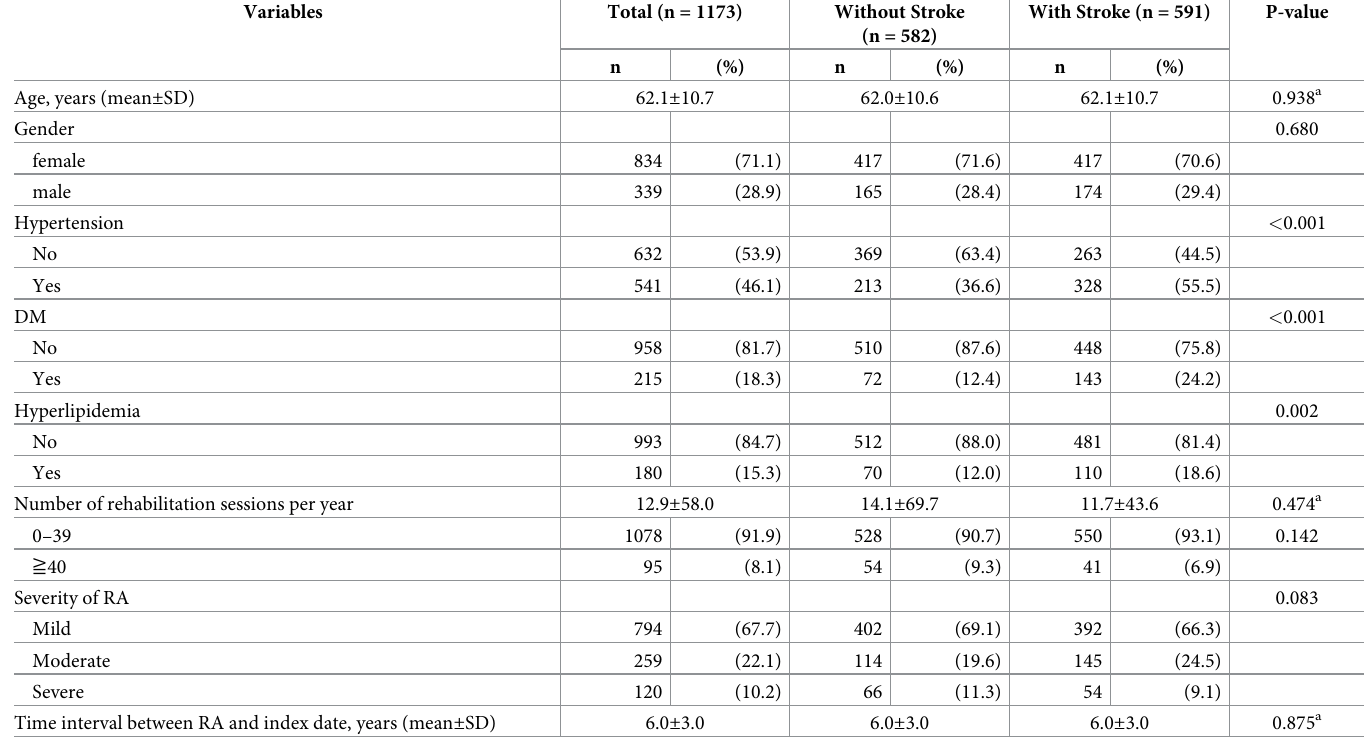
Table 1. Clinical characteristics of RA patients with and without